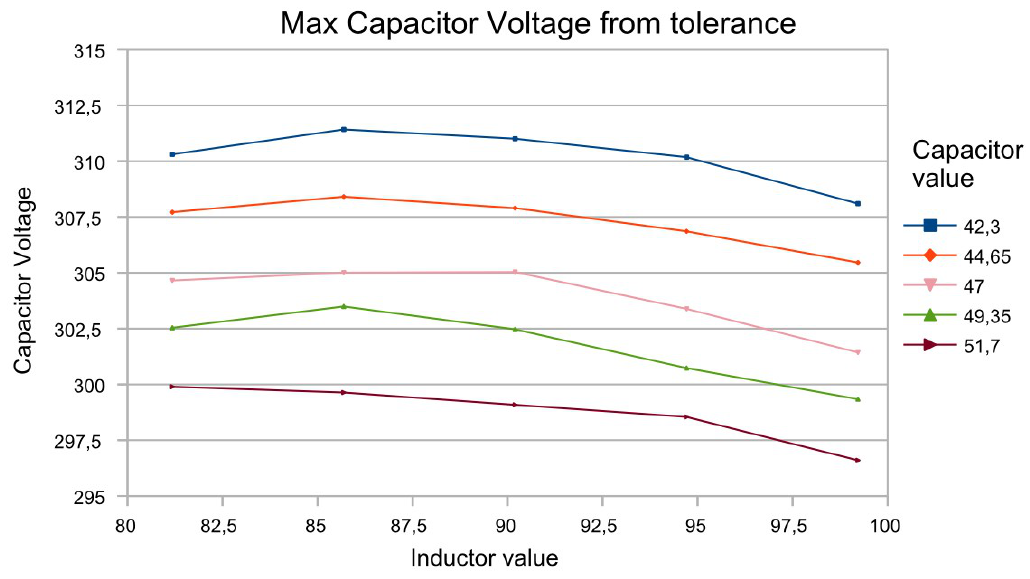
Figure 15. Tolerance analysis of the resonant capacitor voltage with optimized values.